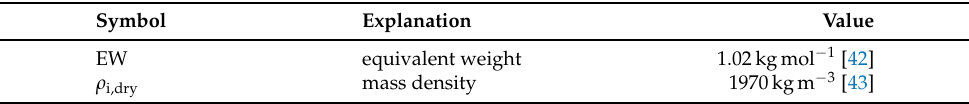
Table A3. Dry ionomer properties (for Nafion-NR-211 type).